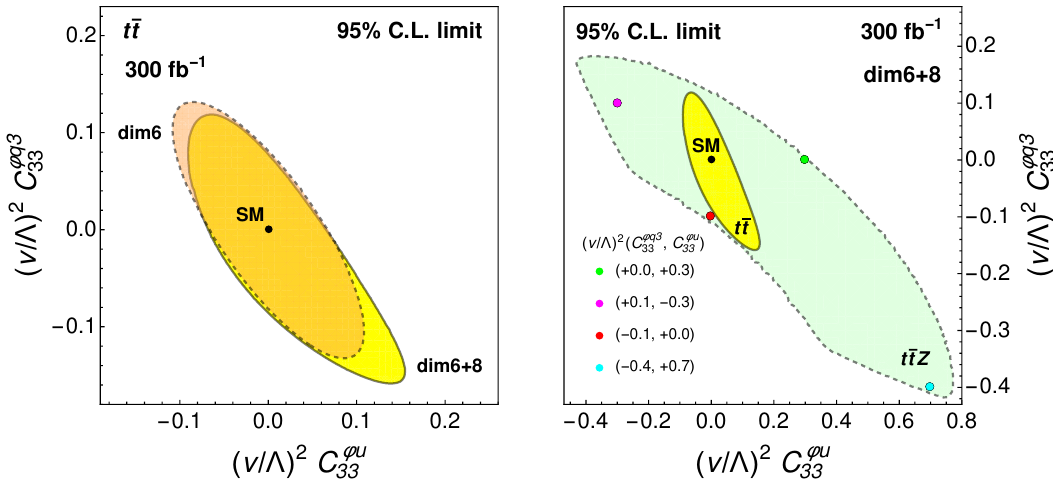
Figure 7 . Left: exclusion limits on EFT coe(cid:14)cients including (yellow, solid) and neglecting (orange, dashed) the squared dimension-six terms. Right: exclusion limits obtained from the p t distributions for t (cid:22) t production including EW corrections (yellow, solid) and the (cid:1) (cid:30) for t (cid:22) t + Z production (light green, dashed). Colored dots correspond to particular values of the EFT